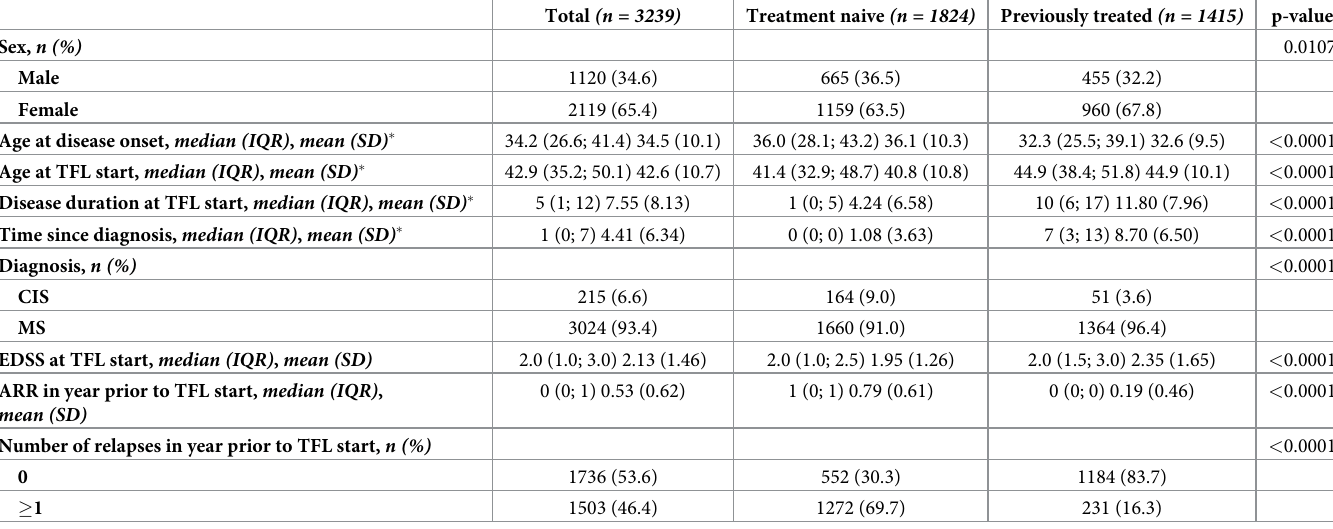
Table 2. Characteristics of the treatment na ï ve and previously treated subgroup at teriflunomide treatment